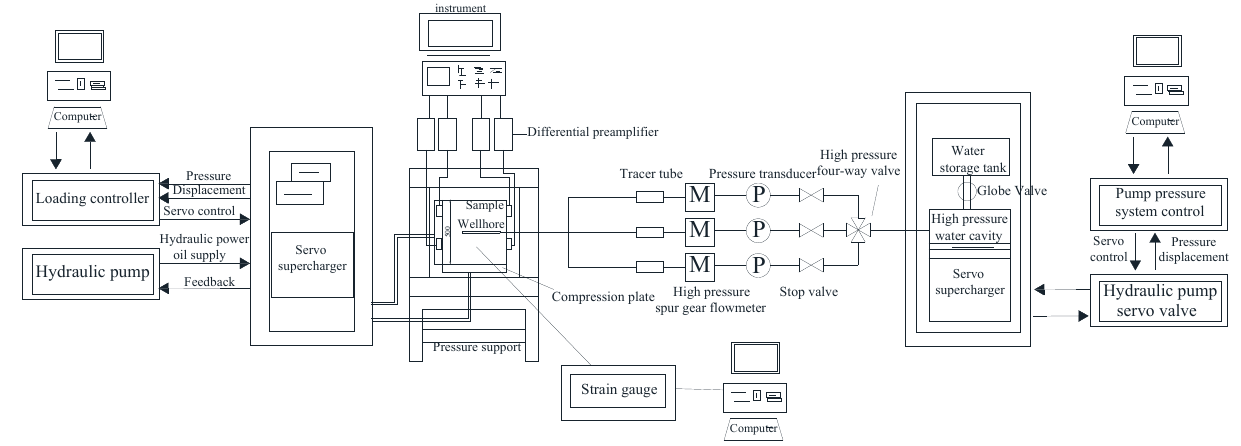
Figure 1. Schematic of experimental equipment.